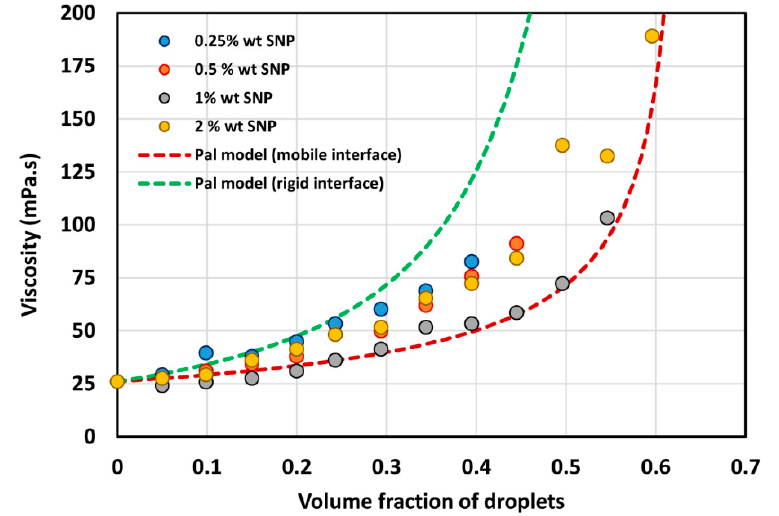
Figure 8. Comparison of experimental viscosity versus volume fraction of water droplets data of W/O emulsions with model predictions.